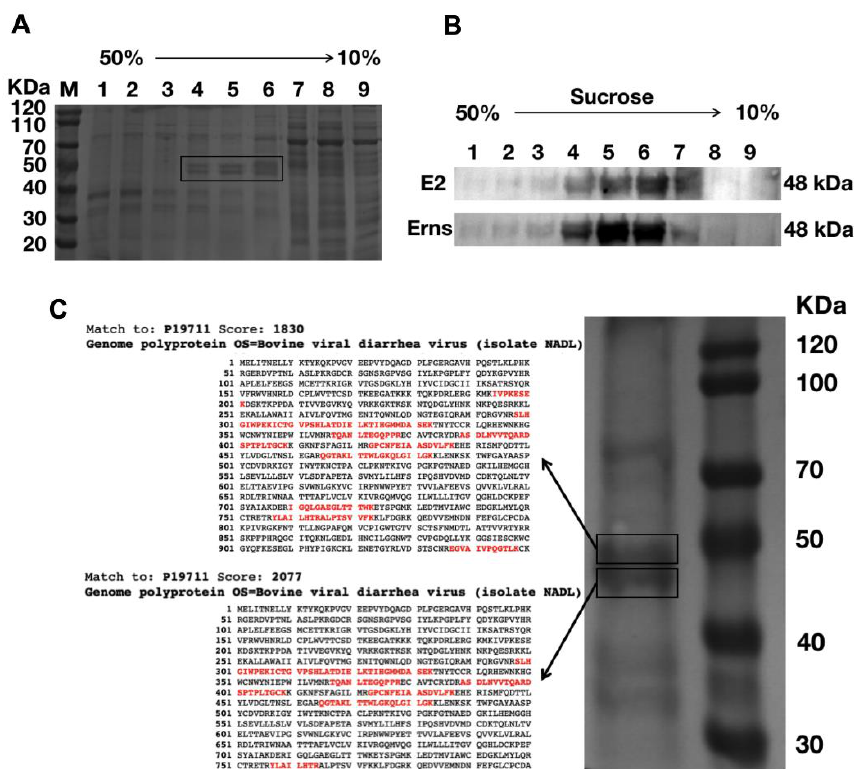
Figure 3. Purification of VLPs by sucrose density centrifugation. VLPs obtained with ultracentrifugation through sucrose density gradient (10%, 20%, 30%, 40%, 50%) at 35,000 rpm, 4 °C, for 3 h in a Beckman SW41 rotor and divided into nine fractions. ( A ) Fractions 1-9 were analyzed by SDS-PAGE and protein bands were visualized with Coomassie Brilliant Blue staining. The E rns and E2 protein bands are highlighted in boxes; M: protein ladder. ( B ) Western blot analysis of fractions of 1-9 with E rns pAb and E2 mAb 348. ( C ) Purified VLPs were subjected to SDS-PAGE and two protein bands migrated to the size of ≈48kDa were identified by LC–MS/MS. The matched peptides are highlighted in bold red; molecular weight (kDa) of the ladder is labelled on the right